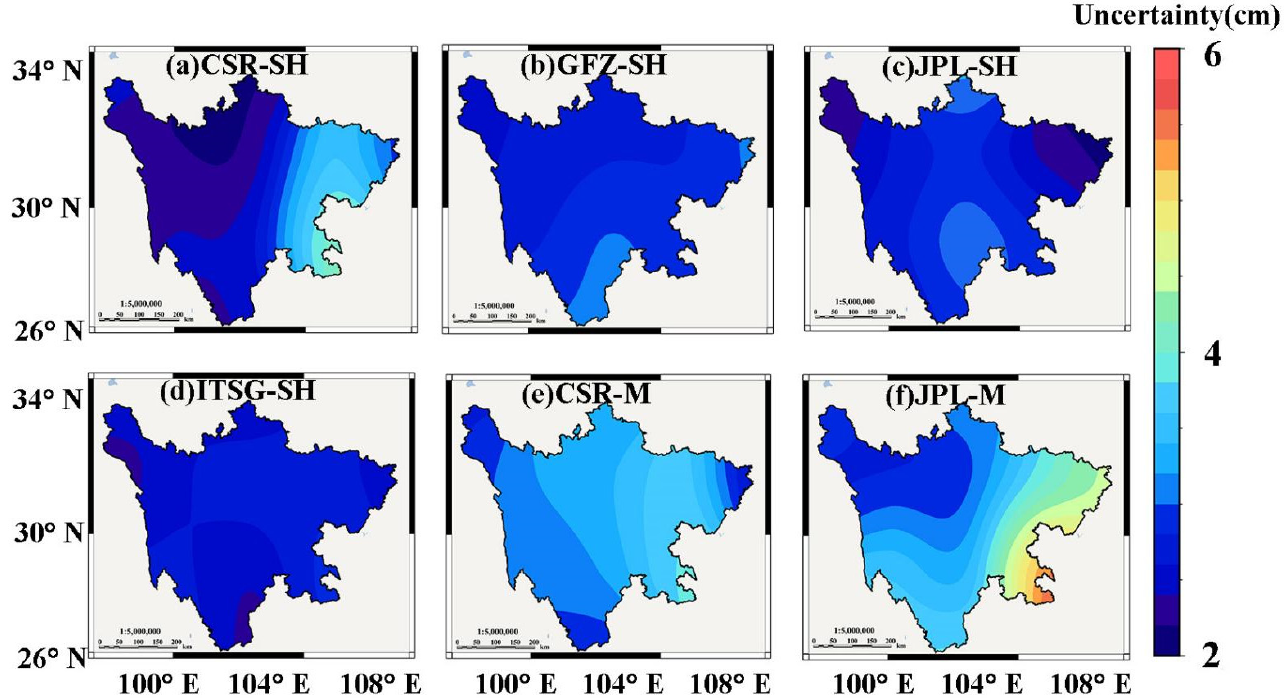
Figure 2. The spatial distribution of uncertainties of the TWSC results derived from the CSR-SH ( a ),